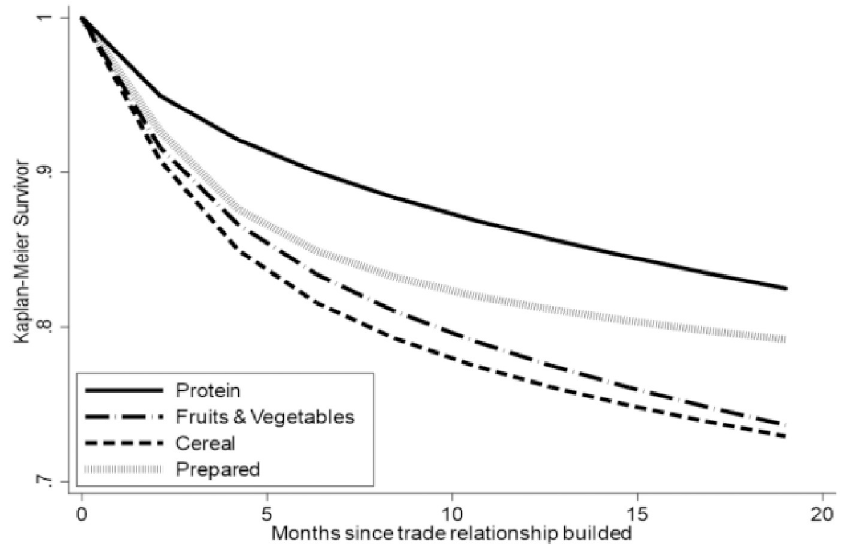
Fig 2. Kaplan-Meier estimator for agri-food